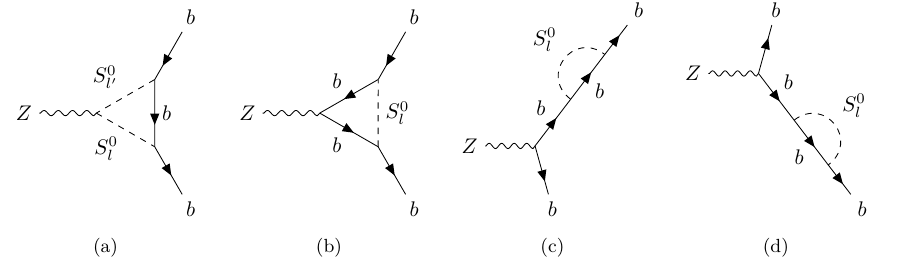
(cid:0) (cid:1) . f R m 2